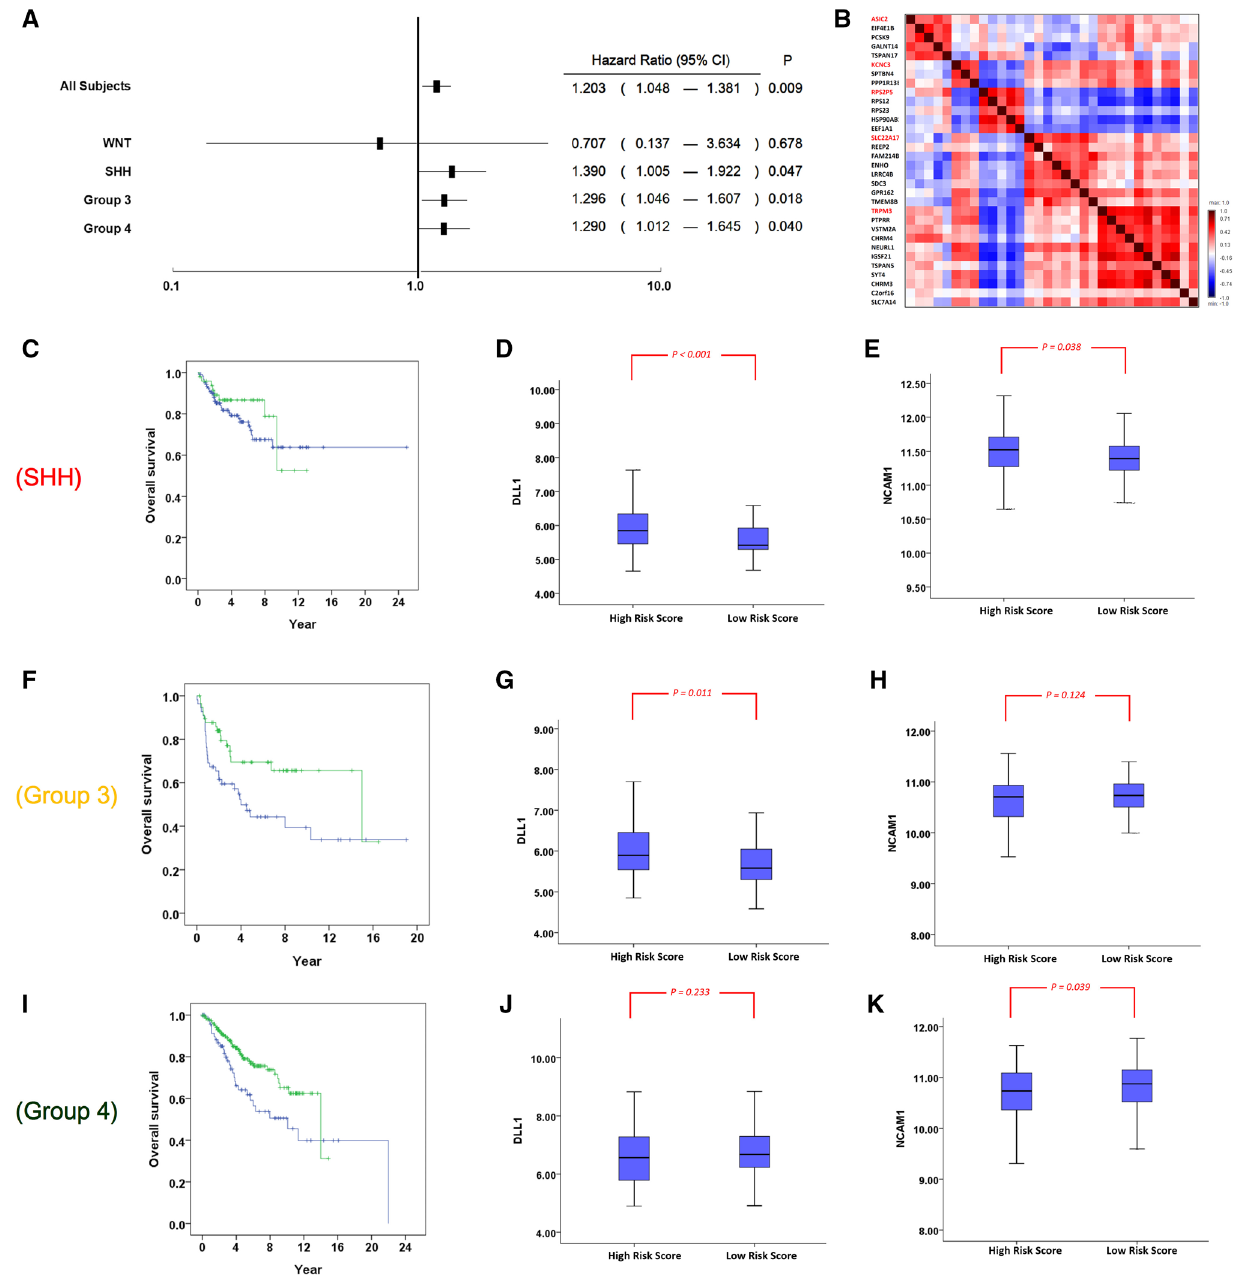
Figure 5. Validation of gene signatures using a large public-domain dataset. ( A ) The forest plot of the gene signature score performance in indicating overall survival of patients in the Canadian cohort and in the molecular subgroups. The score is significantly associated with overall survival in SHH (P = 0.047), Group3 (P = 0.018) and Group 4 (P = 0.040) patients. ( B ) Pairwise correlations of the levels of genes in the core- transferability gene set. ( C – E ) The overall survival, the distributions of DLL1 and NCAM1 genes of SHH patients stratified by median score into high-risk (shown as the blue curve in C ) and low-risk (shown as the green curve in C ) patients. ( F – H ) The overall survival, DLL1 and NCAM2 distributions of patient strata of Group 3. ( I – K ) The overall survival, DLL1 and NCAM2 distributions of patient strata of Group